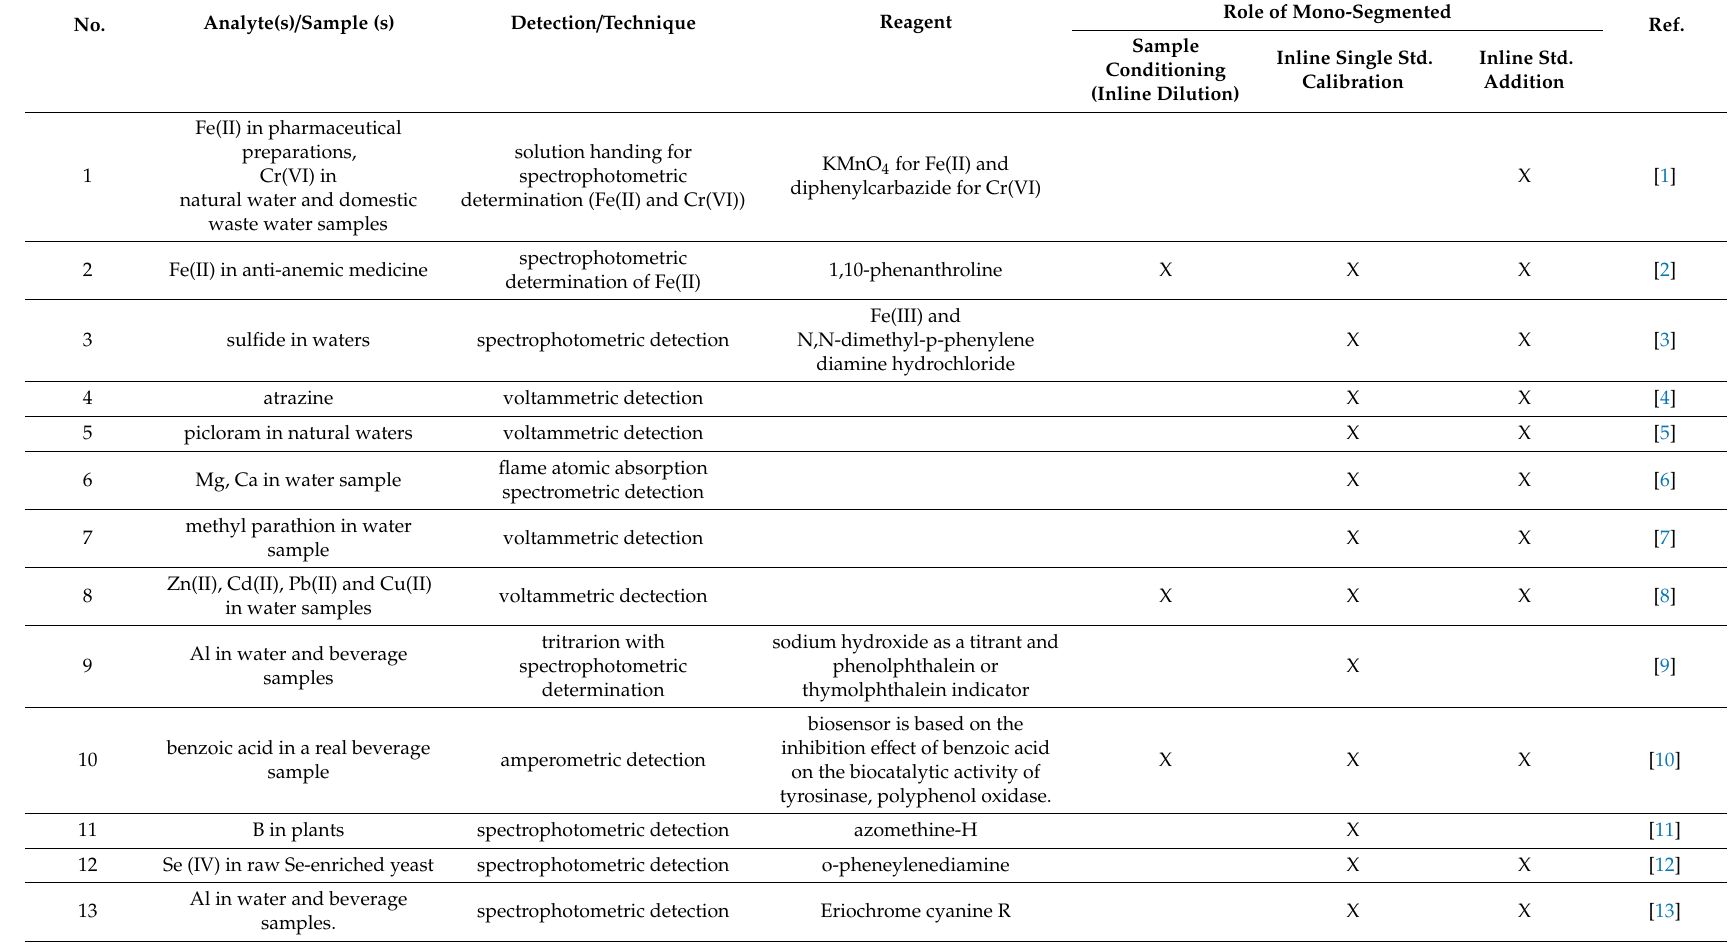
Table 1. Usages of mono-segmentation in sequential injection